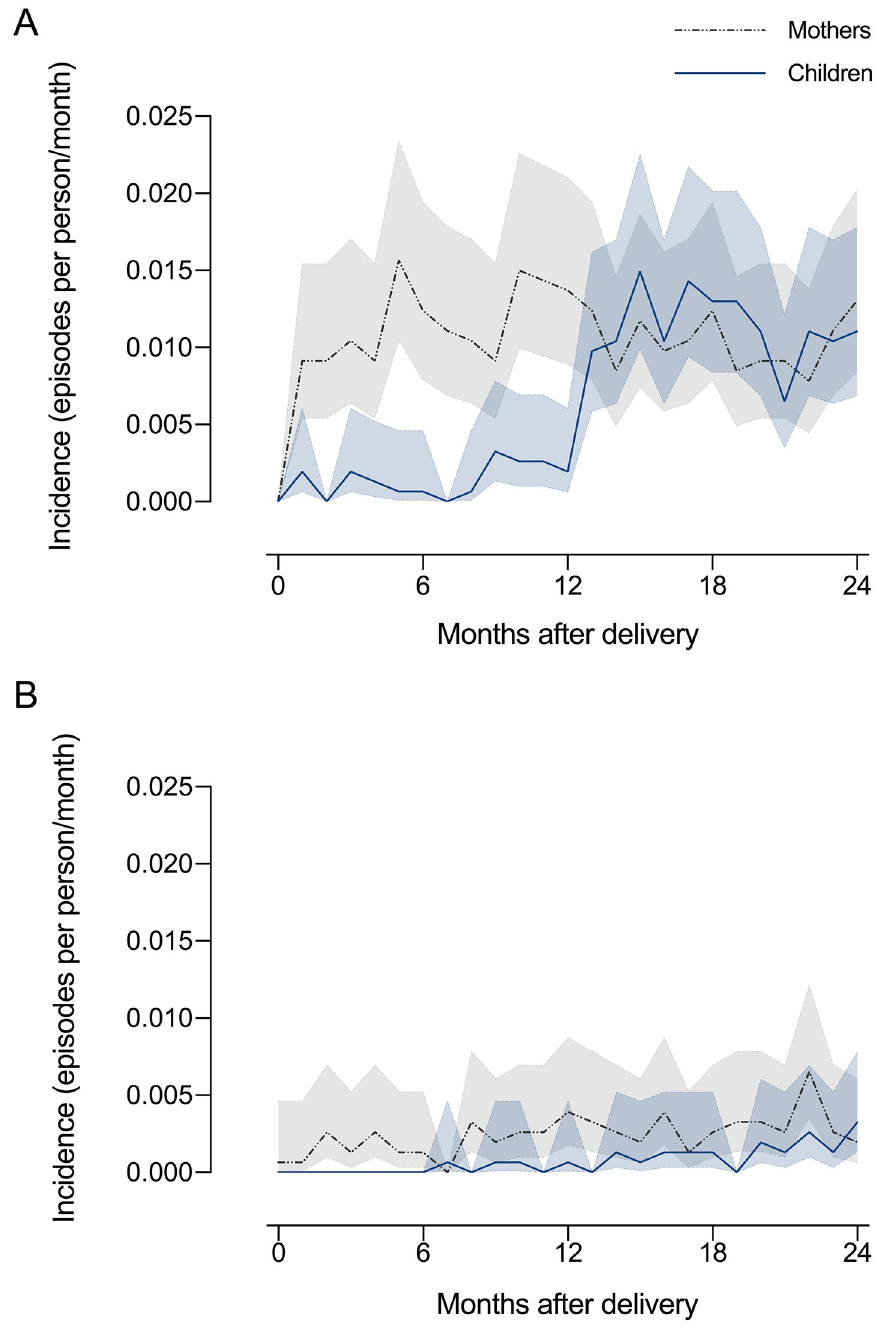
Fig 3. Monthly malaria incidence in mothers and their children. Panel A shows the incidence of laboratory- diagnosed P . vivax malaria and their respective 95% confidence intervals among mothers (n = 1,533) and their children (n = 1,539) participating in the MINA-Brazil study. Panel B shows the incidence of laboratory-diagnosed P . falciparum or mixed-species malaria in mothers and children. Each study participant contributed 2 person-years (24 person-months) of follow-up.